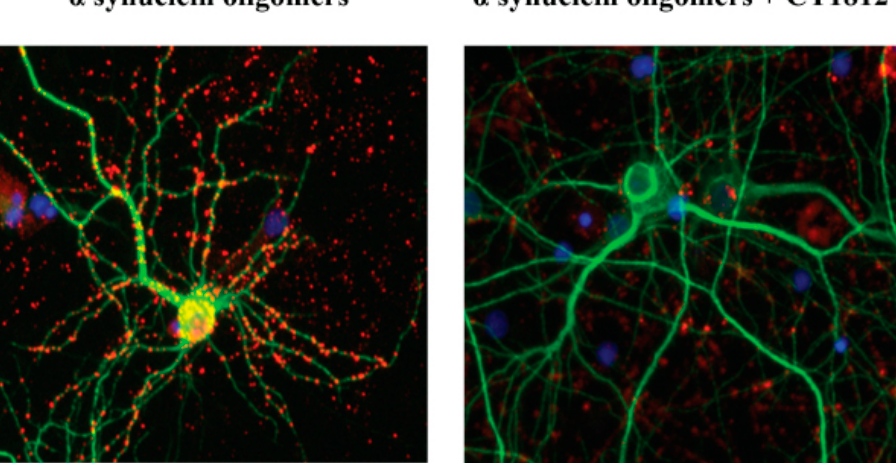
Figure 7. S2R modulators block the effects of α -synuclein oligomer binding to neurons. Representa- tive microscopy images of primary neuronal cell cultures exposed to α -synuclein oligomer are shown with vehicle treatment ( left ) or after the addition of an S2R modulator ( right ). α -Synuclein oligomers (red) bind to neuronal processes (MAP2, green). The addition of an S2R modulator decreases the levels of α -synuclein oligomers bound to neurons [4].